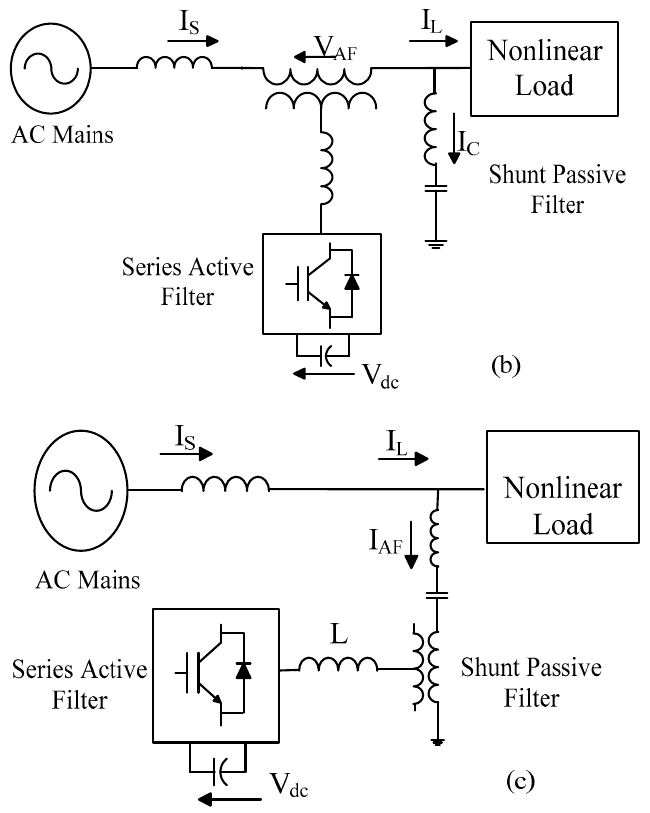
Figure 8. ( a ) Shunt APF with shunt PF; ( b ) Series APF with shunt PF; and ( c ) APF connected in series with shunt PF.